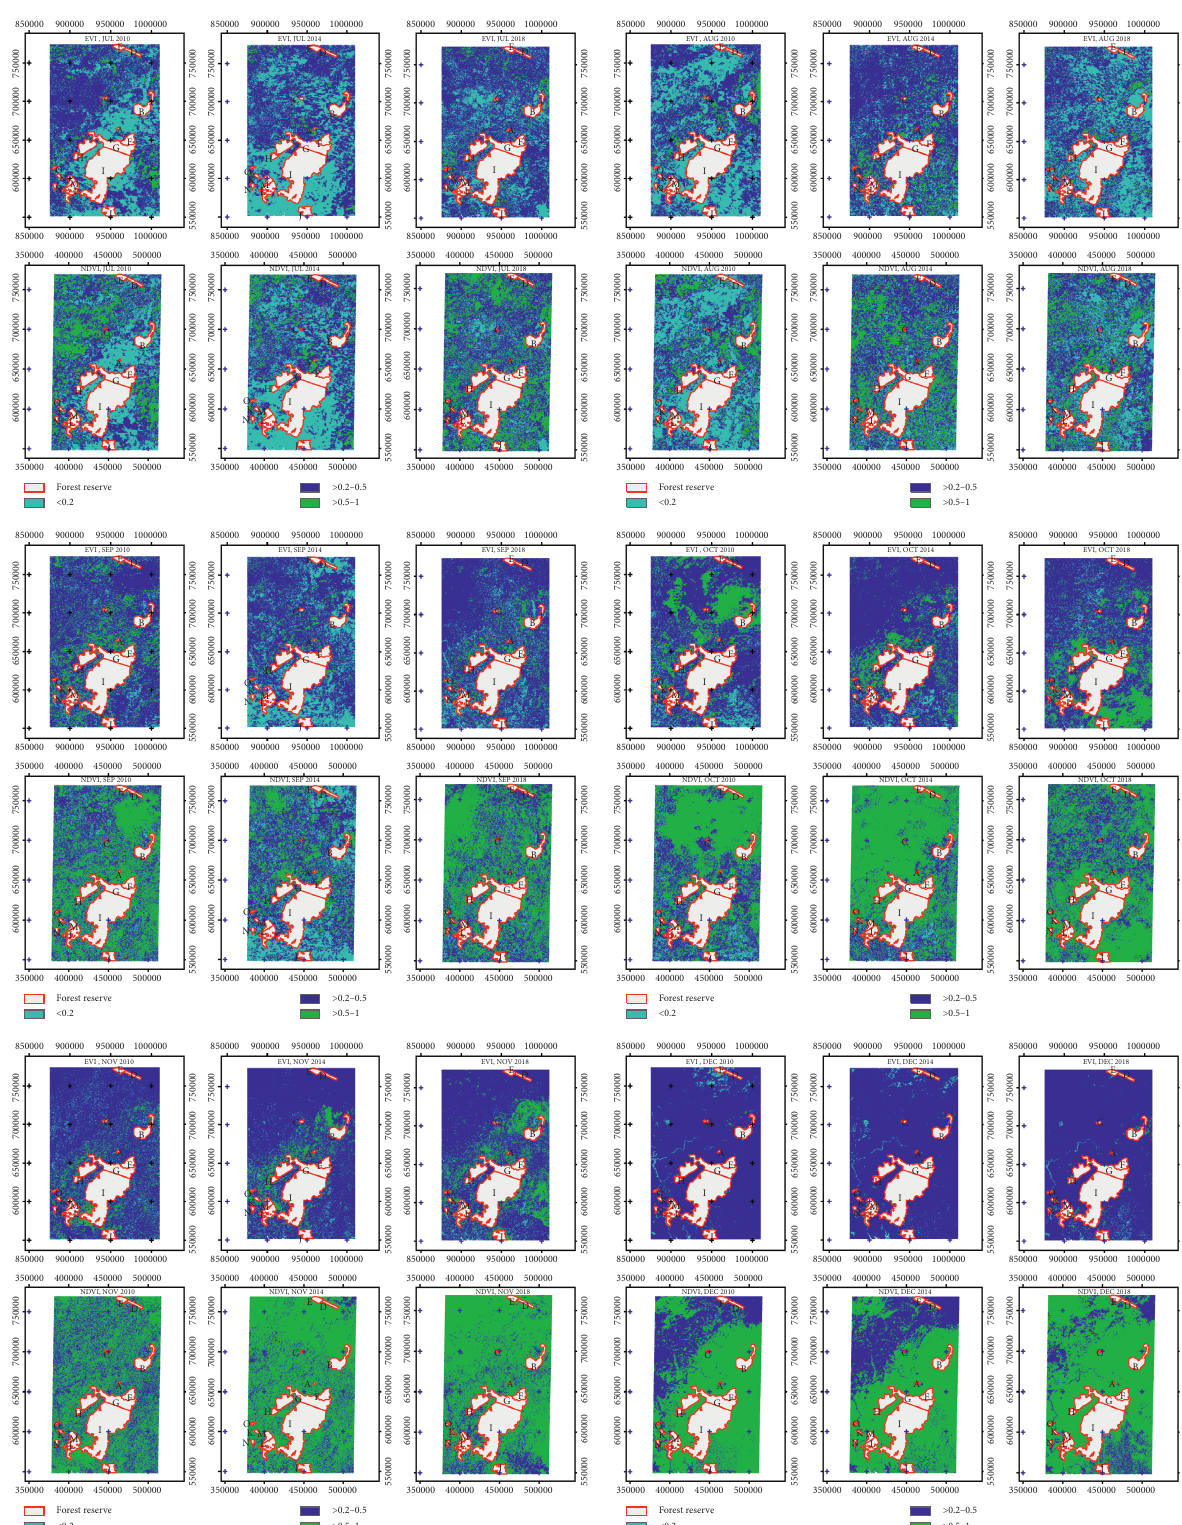
Figure 4: Monthly NDVI and EVI thematic output maps for each of the three